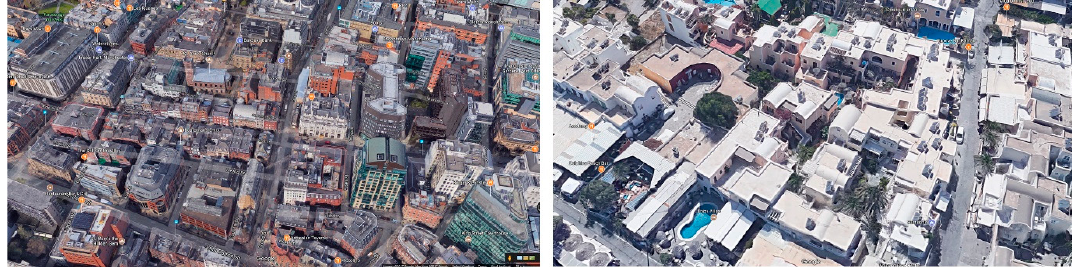
Figure 2. Urban surfaces in Manchester ( left ) versus Santorini ( right ). Images are from Google Earth. Vegetation and water bodies are replaced with buildings and roads in cities. Vegetation can reduce